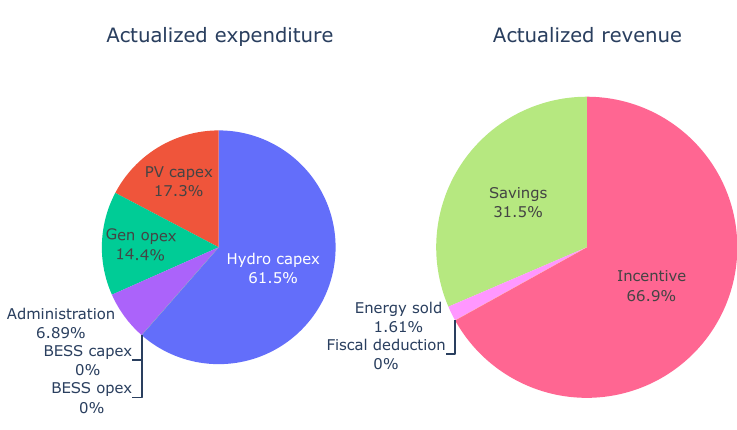
Figure 11. Cash flow